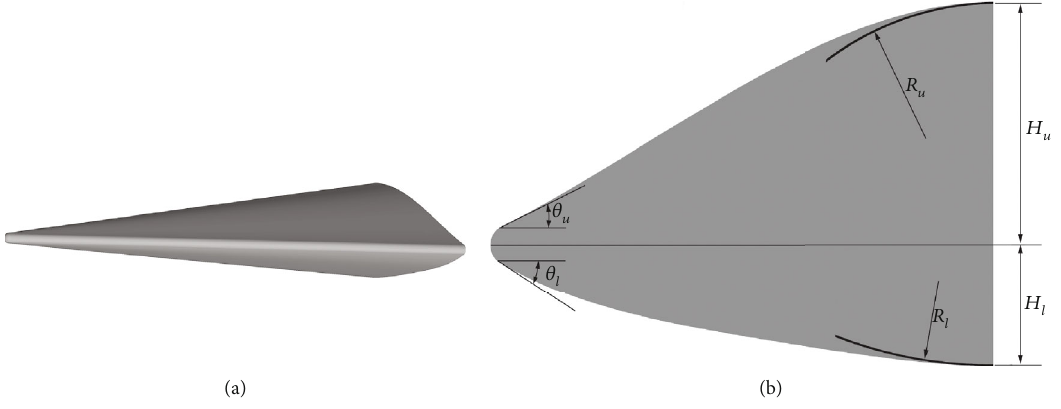
Figure 1: The baseline: (a) con fi guration and (b) after-body